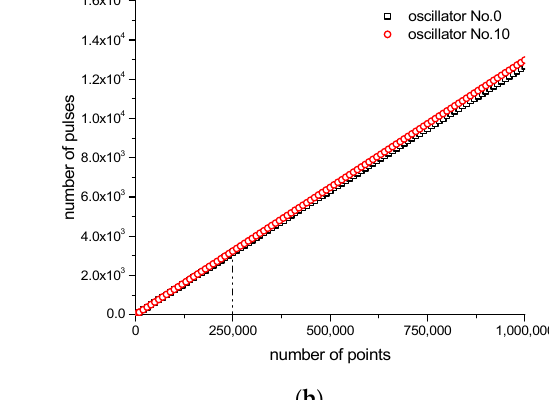
Figure A5. The dependence of η ( a ) and the number of pulses ( b ) on the number of points on the oscillogram. The dashed line corresponds to 250,000 oscillogram points.